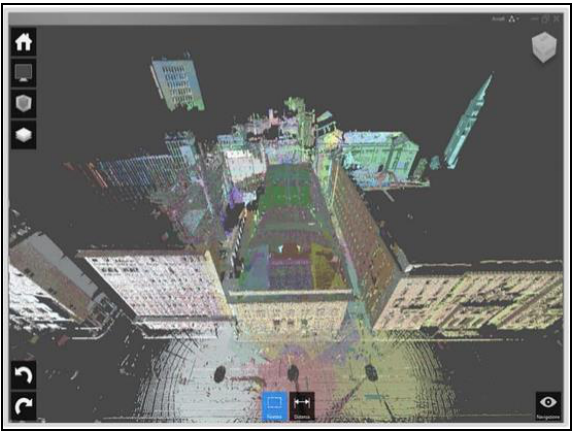
Figure 1. Point cloud of the exterior of the Lyric Theatre Source: Municipality of Milan